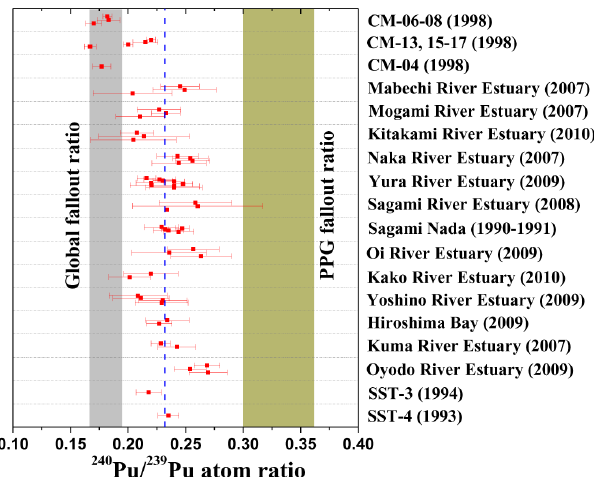
Fig. 3. The 240 Pu/ 239 Pu atom ratio distribution in Japanese near- coast surface sediments. The years shown in the brackets are the sampling dates. The areas shaded in grey and light green represent the 240 Pu/ 239 Pu atom ratio ranges of global fallout (0.180 ± 0.014) and PPG close-in fallout (0.30–0.36), respectively. The atom ratio ranged from 0.170–0.270. For the eastern estuaries facing the North Pacific, the average 240 Pu/ 239 Pu atom ratio was 0.231 ± 0.025 ( n = 36). The blue dotted line is the mean atom ratio value (0.231). Data for CM-06-08, CM-13, 15–17, Mabechi River Estuary, Mogami River Estuary, Yura River Estuary, Kuma River Estuary, SST-3 and SST-4 are cited from the literature (NIRS, 2010; Zheng and Ya- mada, 2005, 2006b,